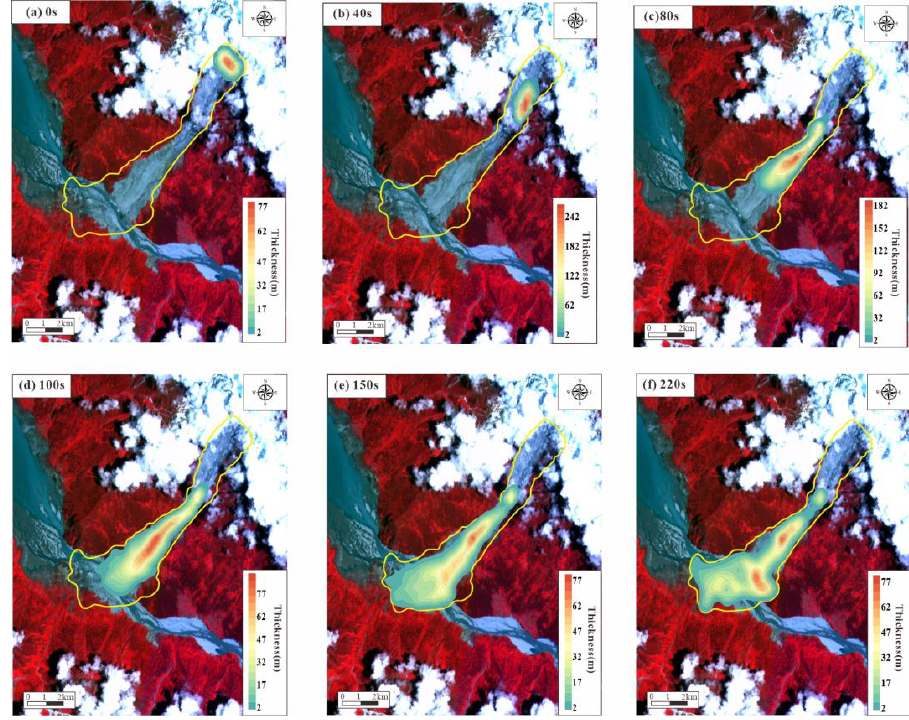
Figure 9. Contour map of the simulation process under normal simulation condition. ( a – f ) show six typical contour maps selected from the simulation process of 0 s – 220 s. The yellow line represents the maximum range of landslide in the simulation process.